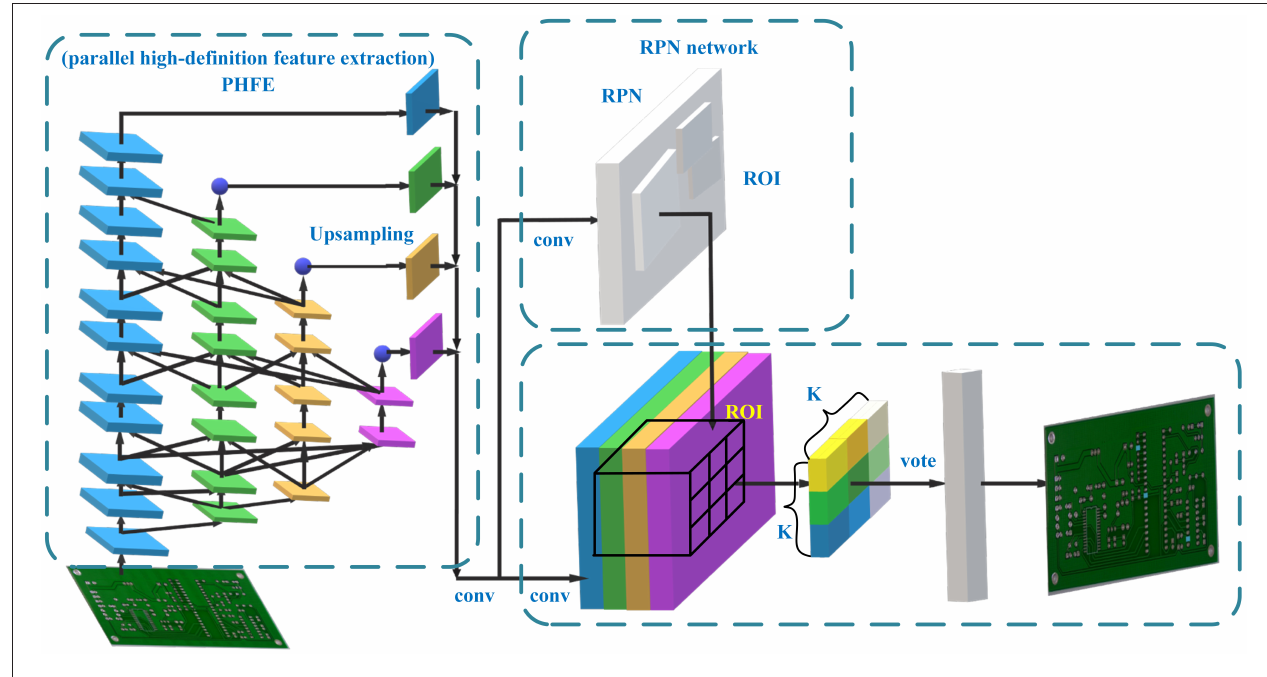
FIGURE 1 | The structure of the minor defect recognition network in PCB.